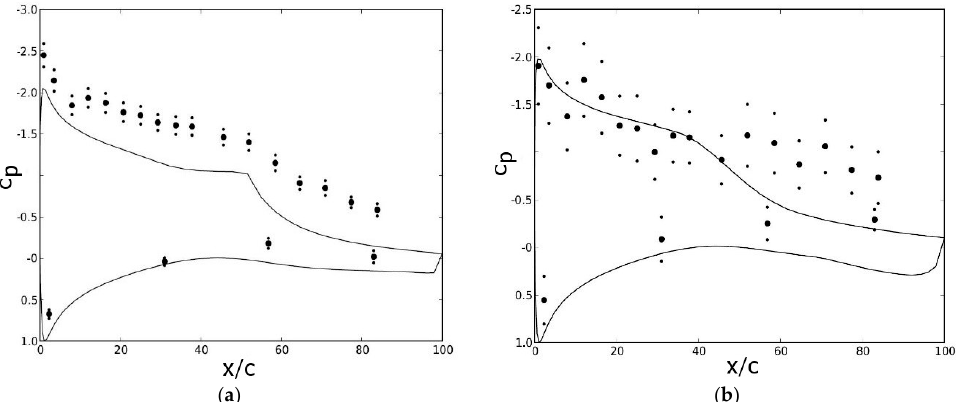
Figure 36. Wall pressure coefficient measurements (large circles: averages, small circles: uncertainty) and XFoil predictions (solid line) for α = 8.5 degrees and ( a ) Re = 115,000 and ( b ) Re = 64,200. (Reprinted by permission of the American Institute of Aeronautics and Astronautics, Inc. (Reston, VA, USA) from [37]).